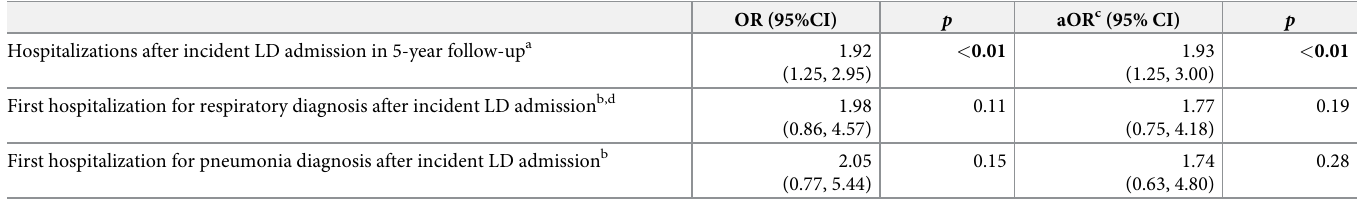
Table 3. Crude and adjusted odds ratios for subsequent hospitalizations between ICU versus non-ICU admitted veterans hospitalized for Legionnaires’ disease in any U.S. VA medical facility, 2005–2010.